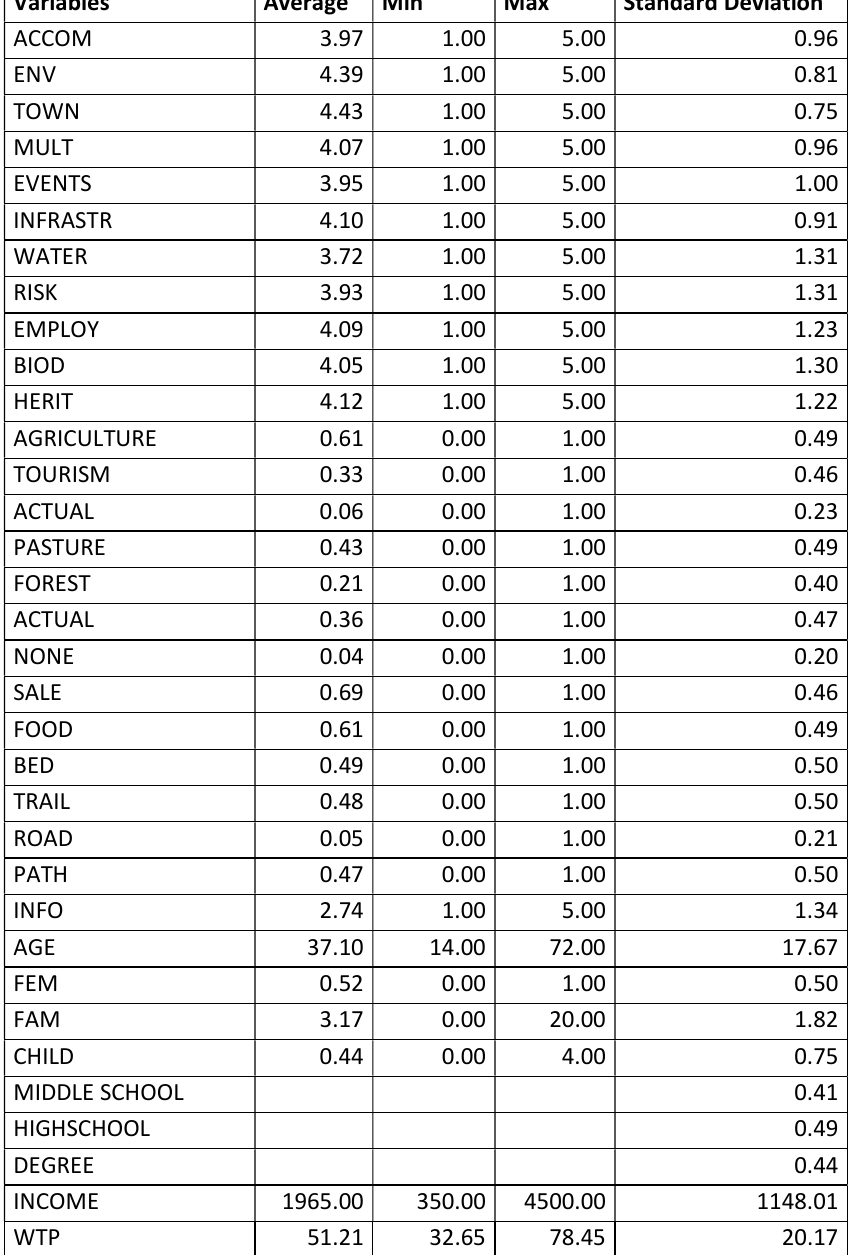
Table 3: Descriptive statistics of the